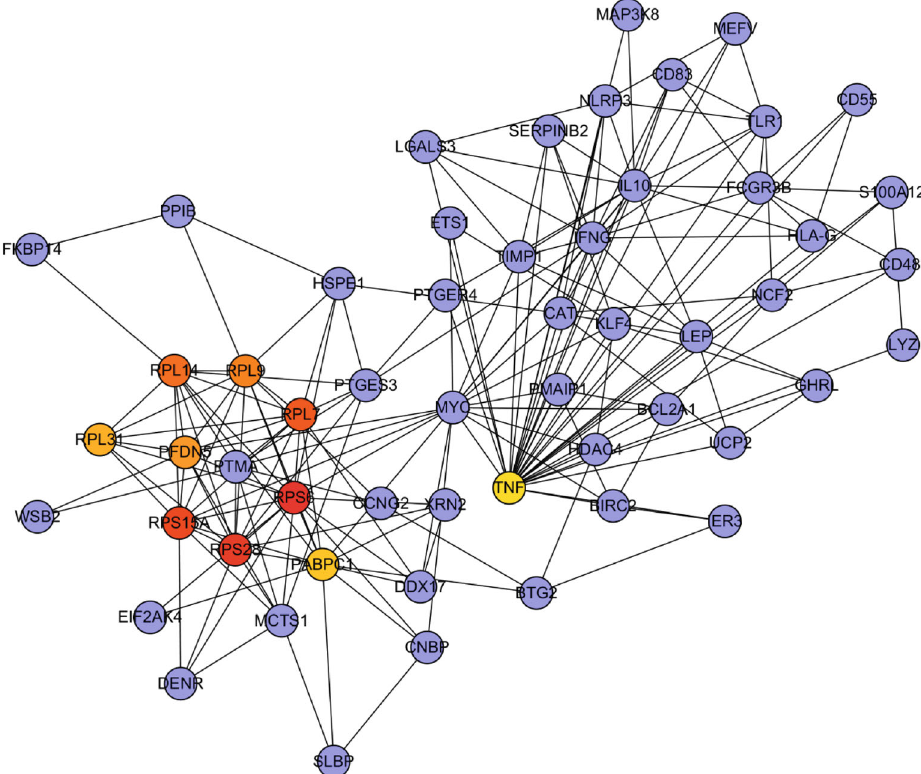
Figure 7: Core gene clusters in the co-expression network constructed from female IS patients. The depth of color indicated the levels of the central genes from low to